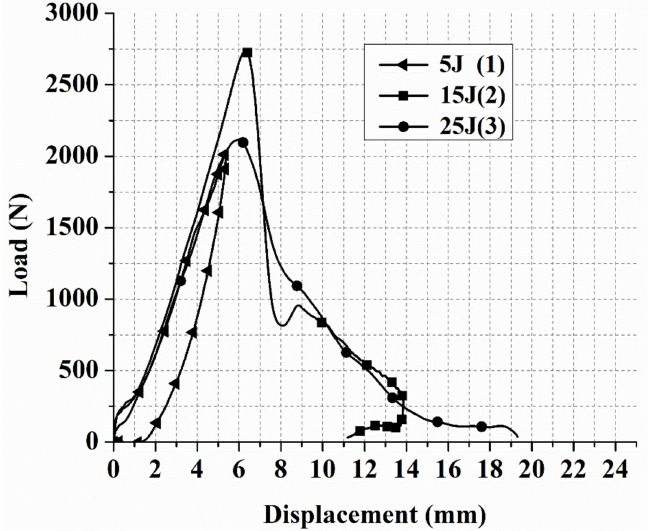
Figure 9. Load–displacement curves for low-velocity impact tests of laminate composites with [B/B] at 5, 15, and 25